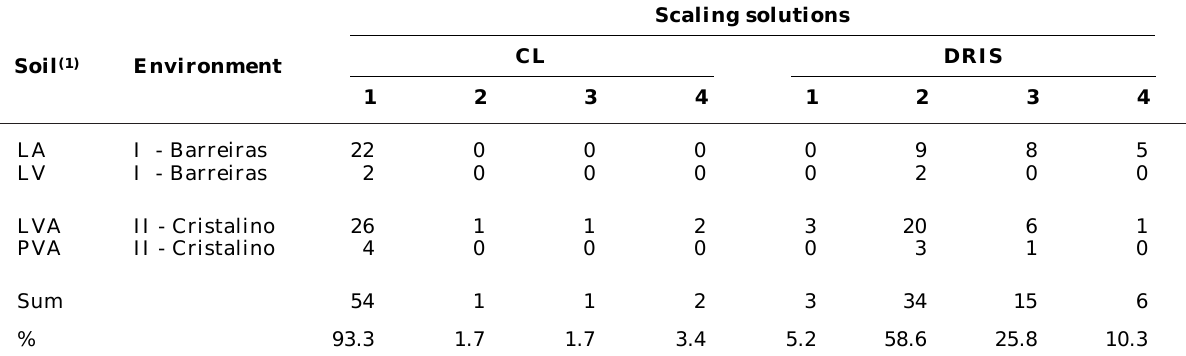
(1) LA: Yellow Latossol, LV: Red Latossol, LVA: Red-Yellow Latossol, PVA: Red-Yellow Argissol.